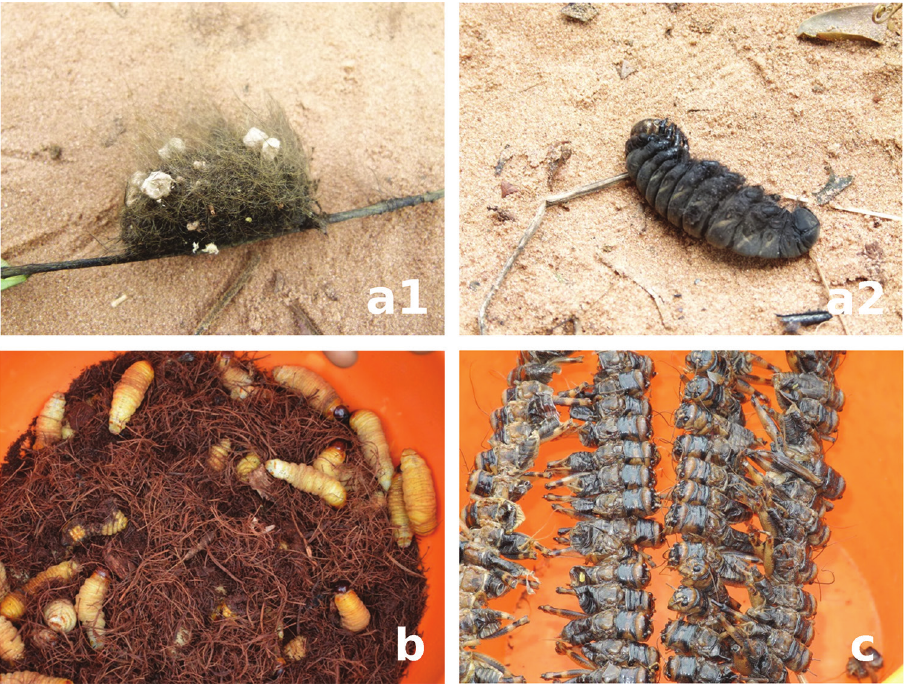
Figure 5. Photographs of edible larvae of Lasiocampidae ( a ), Curculionidae ( b ), photo taken by Barbara Ditsch and Gryllidae (c) collected in the Province Uíge. a Gastroplakaeis rubroanalis (1) in cocoon and (2) without b Rhynchophorus phoenicis c Brachytrupes